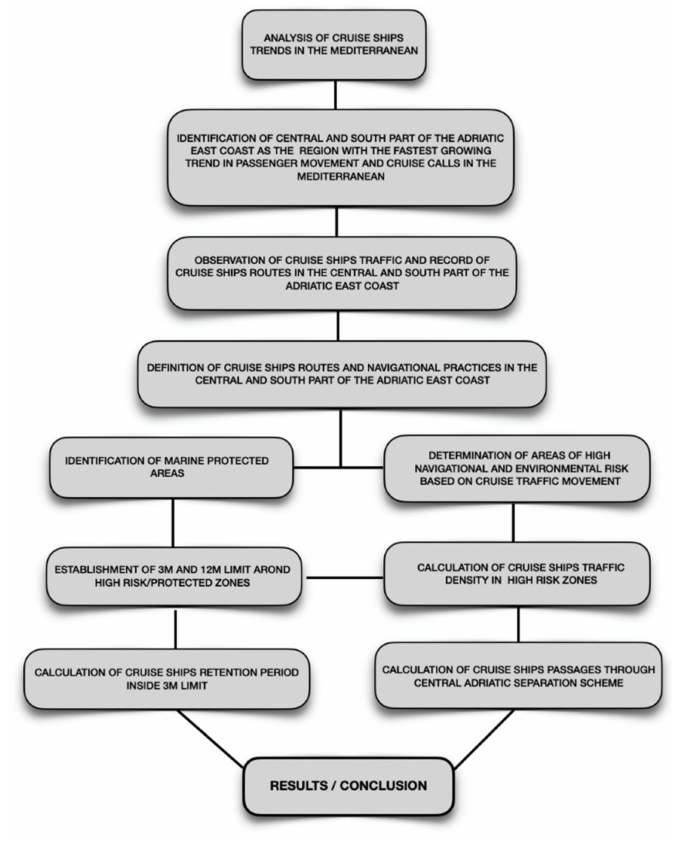
Figure 6. Research methodology